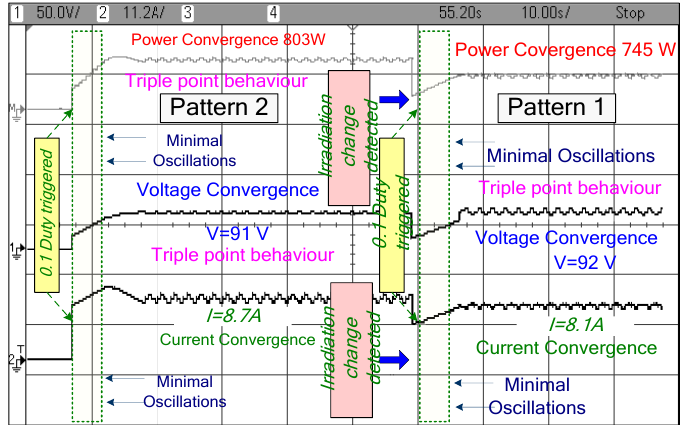
Figure 11. Hardware experimentation of the two-phase HC method.